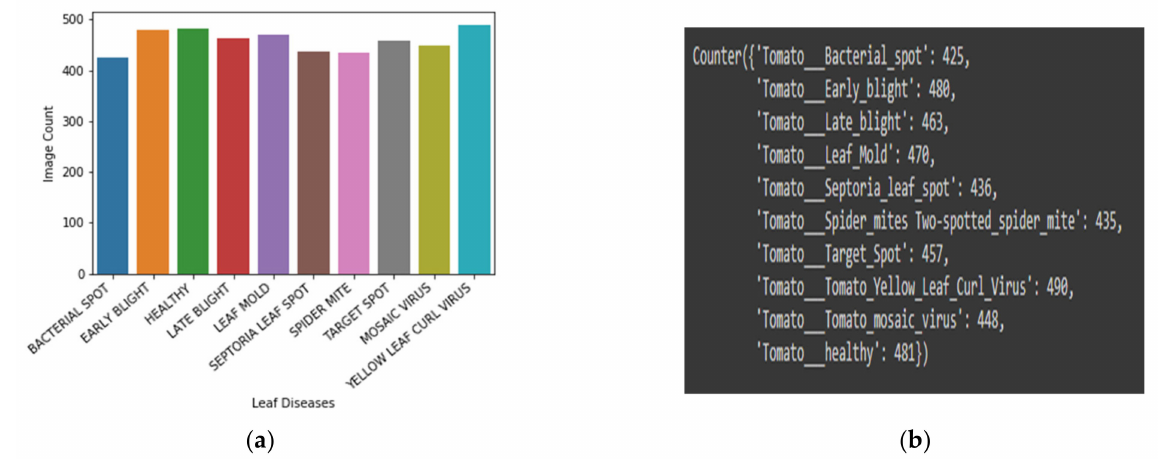
Figure 3. ( a ) The image count of each tomato leave disease in testing data. ( b ) The part of the code for tomato leaf disease detection using CNN